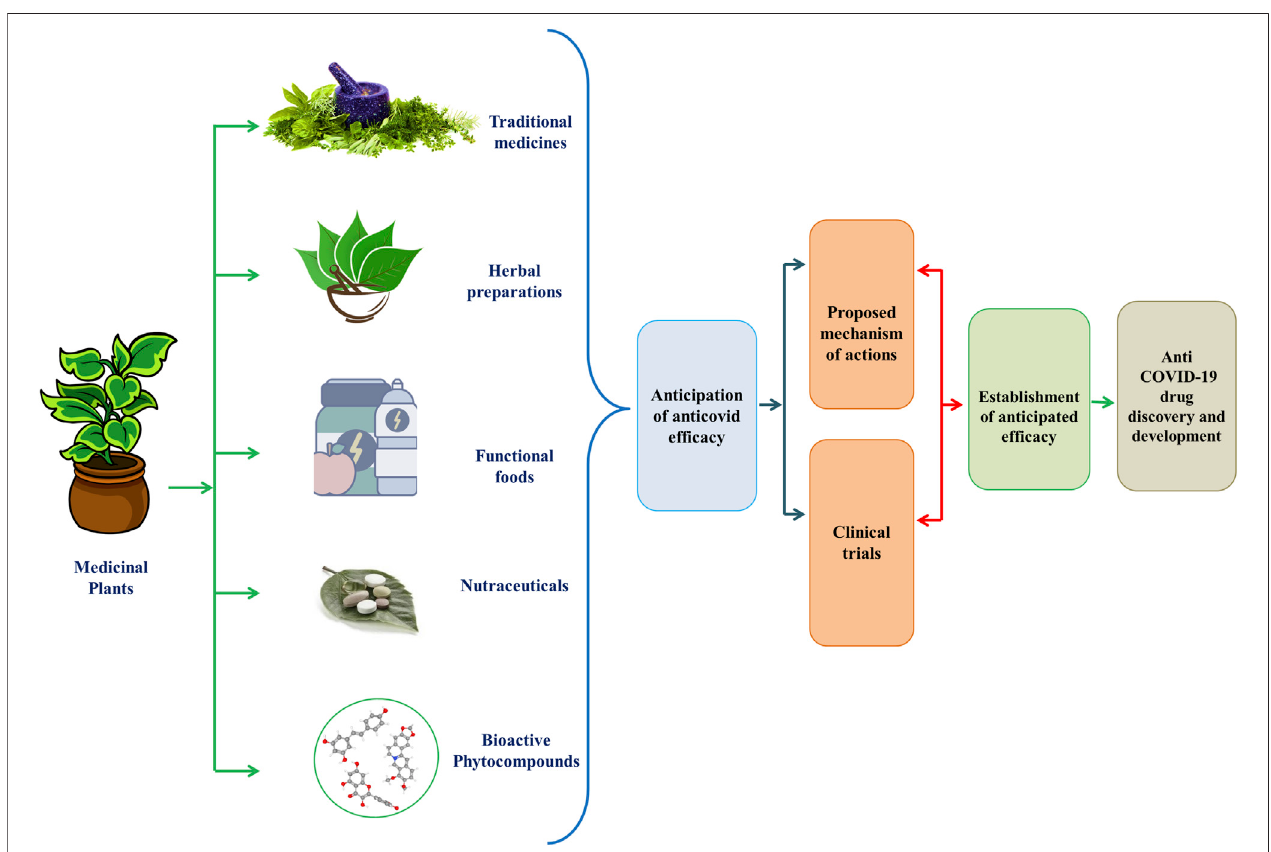
FIGURE 1 | Graphical Abstract of Phytomedicines/Herbal Medicines/Bioactive compounds/Functional Foods/Nutraceuticals for the development of anti-COVID- 19 therapies.